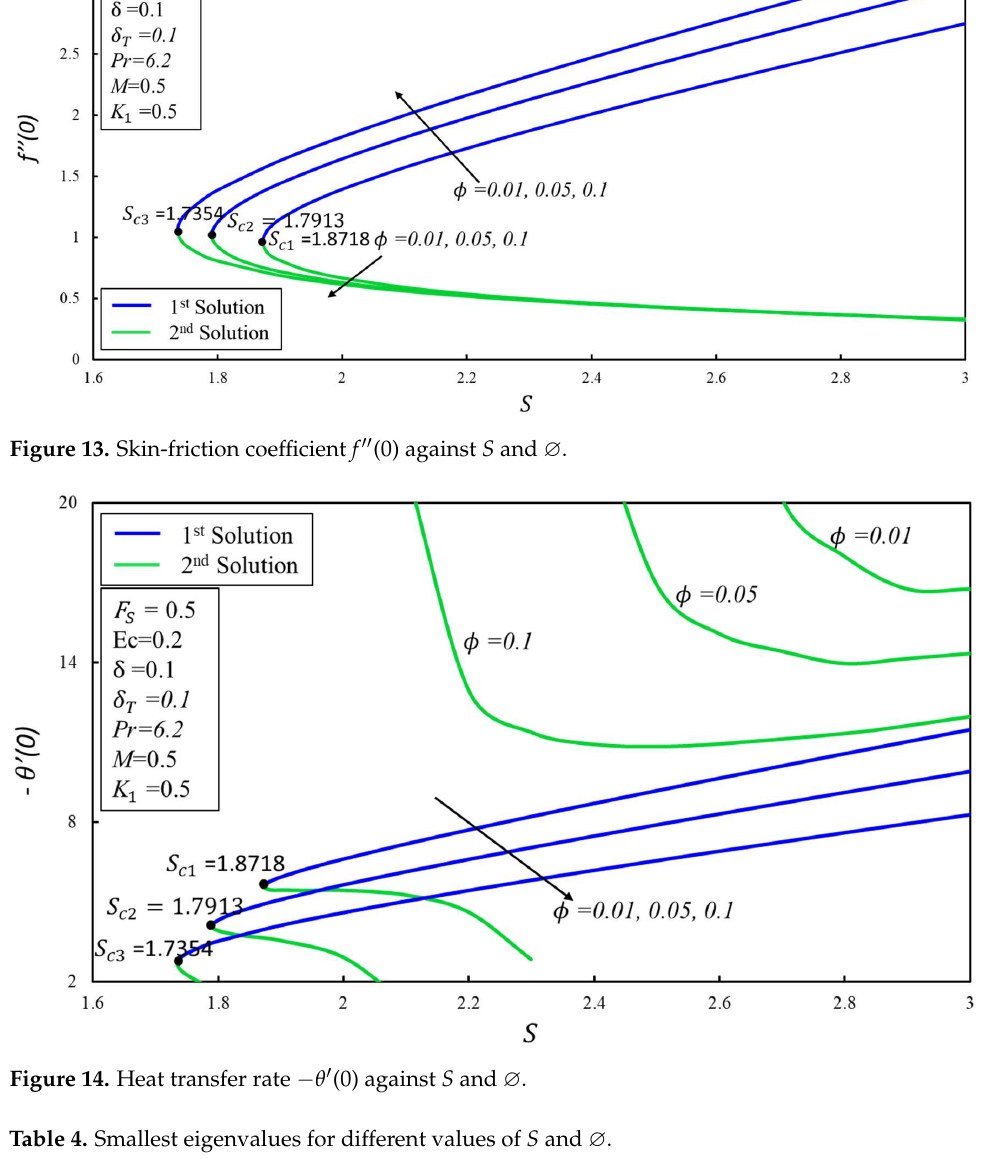
Figure 14. Heat transfer rate −𝜃′(0) against 𝑆 and ∅ . Table 4. Smallest eigenvalues for different values of S and ∅